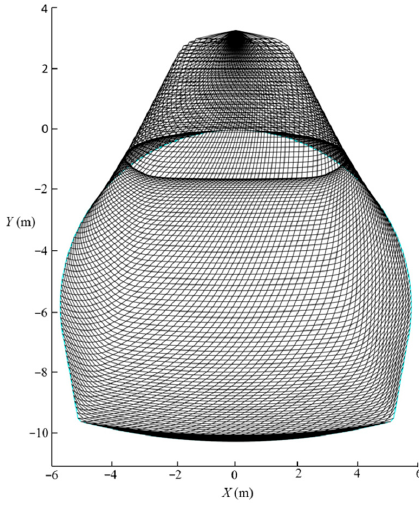
Figure 4. 3D failure surface.